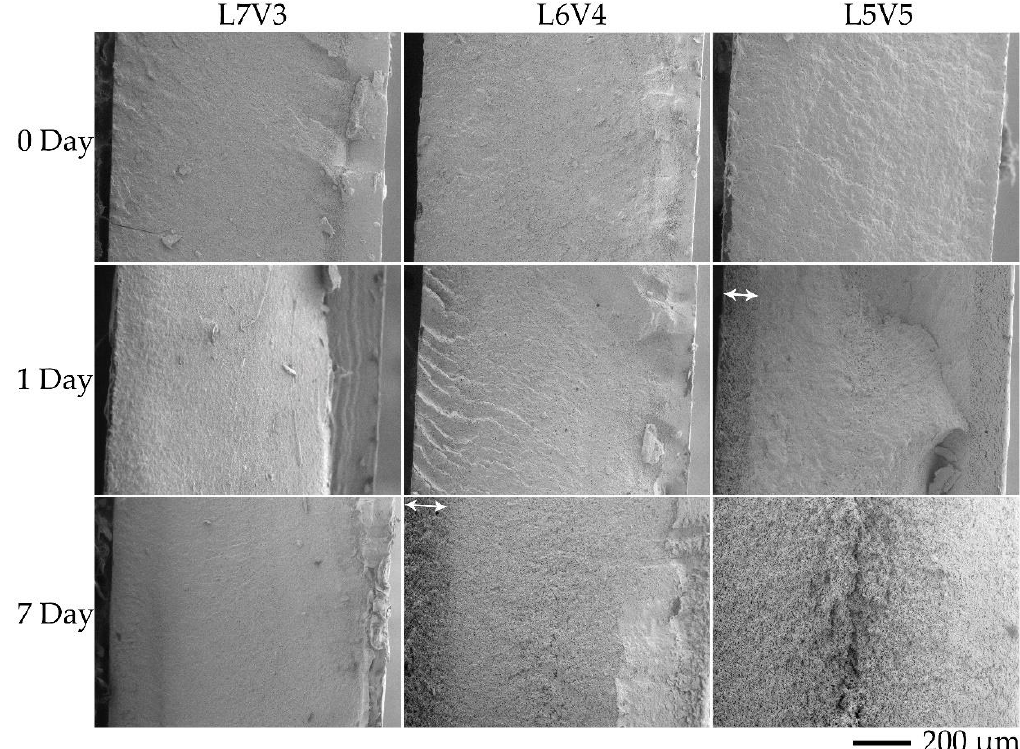
Figure 8. SEM micrographs of the blends in transverse direction (TD) at (I) and (II) locations.